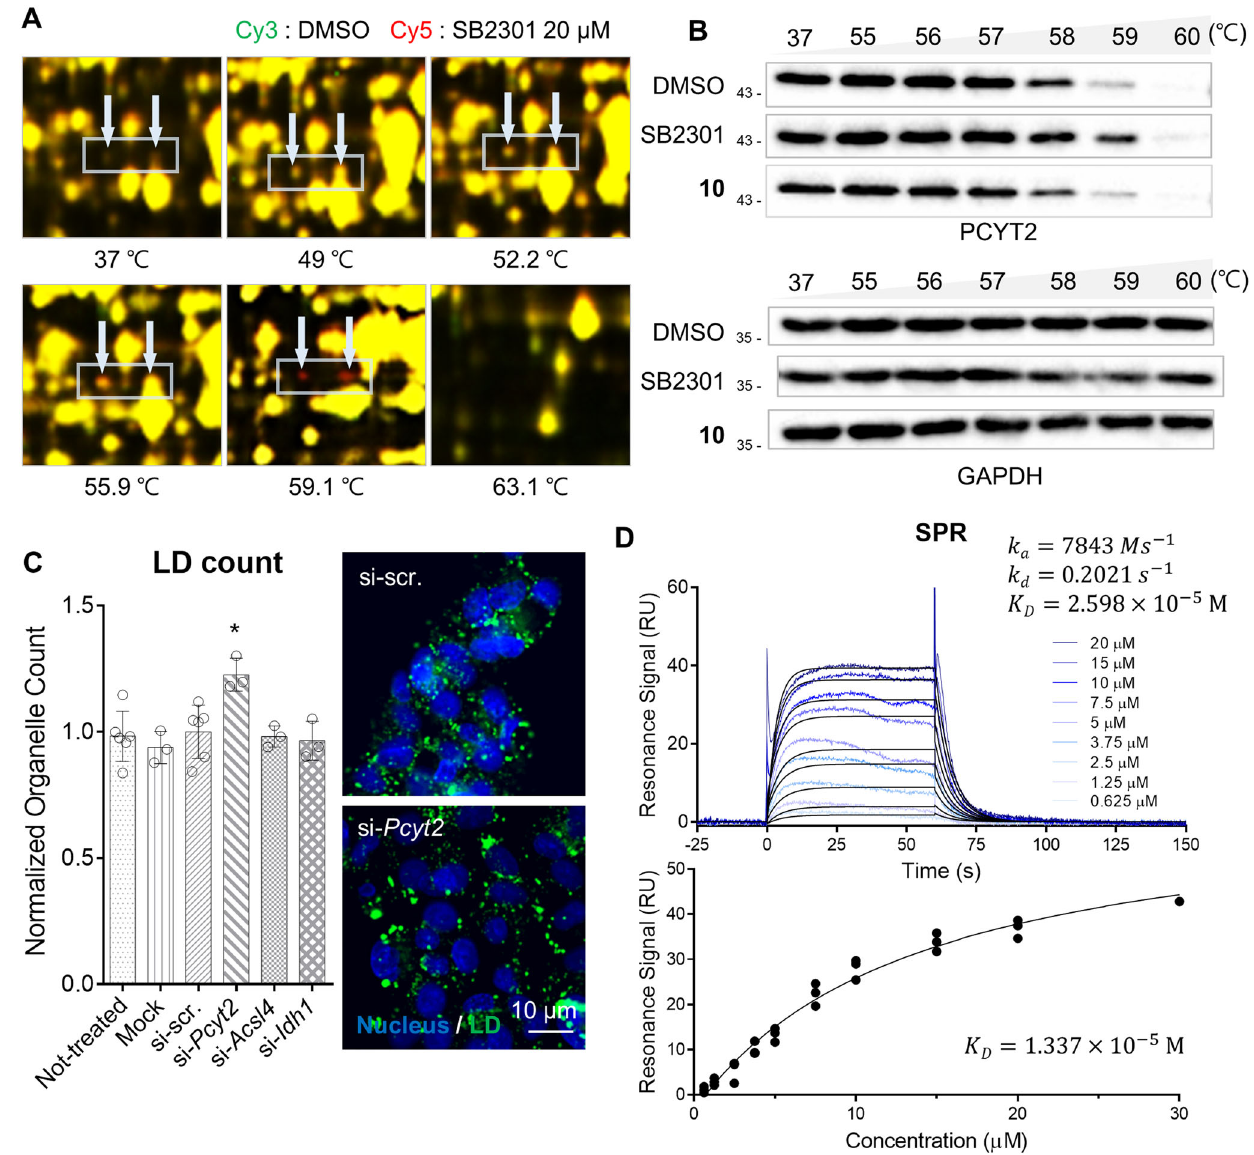
Fig. 3 Identi fi cation of PCYT2 as a target protein of SB2301 by TS-FITGE. A Overlaid images of the Cy3 (green, DMSO-treated proteome) and Cy5 channel (red, SB2301-treated proteome). Indicated spots (white arrow) turned red at 59.1 °C then disappeared at 63.1 °C. B Immunoblot from CETSA representing the speci fi c binding of SB2301 with PCYT2. 20 μ M of SB2301 and negative compound ( 10 ) were treated on HepG2 cells for 1 h. C LD count changes upon depletion of Pcyt2 , Acsl4 , and Idh1 using the respective siRNAs. HepG2 cells were transfected with siRNAs for 48 h, and then the fl uorescent LD images were obtained. All data are represented as dot plots with the mean ± SD, ( n = 3). Data were analyzed using an unpaired t -test. * P = 0.0123 vs. si-scr. D Representative sensorgrams of surface plasmon resonance (SPR) analysis of SB2301 binding to human PCYT2. The equilibrium dissociation constant (K D ) was calculated after 1:1 fi tting with kinetic (upper) or af fi nity mode total cellular LD volume was reduced to 64.2% at 24 h (Fig. 4F). However, the LD volume distribution did not return to its original pattern even after SB2301 treatment under Atg5 - (Fig. 4G, H, and Supplementary Fig. 21 for SB2301; Supple- mentary Figs. 20, 21 for DMSO) or Ubb -knockdown conditions (Fig. 4J, I, and Supplementary Fig. 21 for SB2301; Supplemen- tary Figs. 20, 21 for DMSO). From these observations, we inferred that SB2301 treatment induced the translocation of PCYT2 at the LD surface and that the PE/PC ratio increased at the LD membrane, leading to LD coalescence. LD fusion via a rise in the PE/PC ratio occurred fi rst regardless of autophagy. The resulting unfavorable large LDs may trigger ubiquitin- mediated lipophagy.